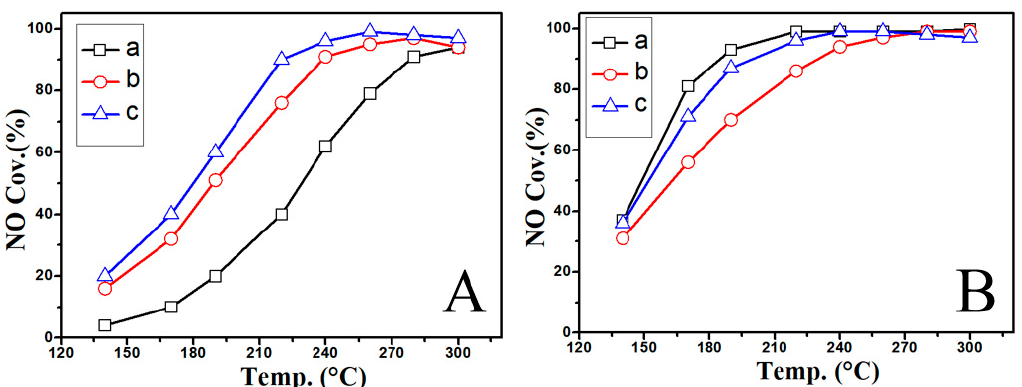
Figure 1. The activity of the powdery ( A ) and honeycomb ( B ) catalysts with different titanium sources: ( a ) filter cake, ( b ) industrial titanium dioxide, and ( c ) filter cake plus titanium dioxide.